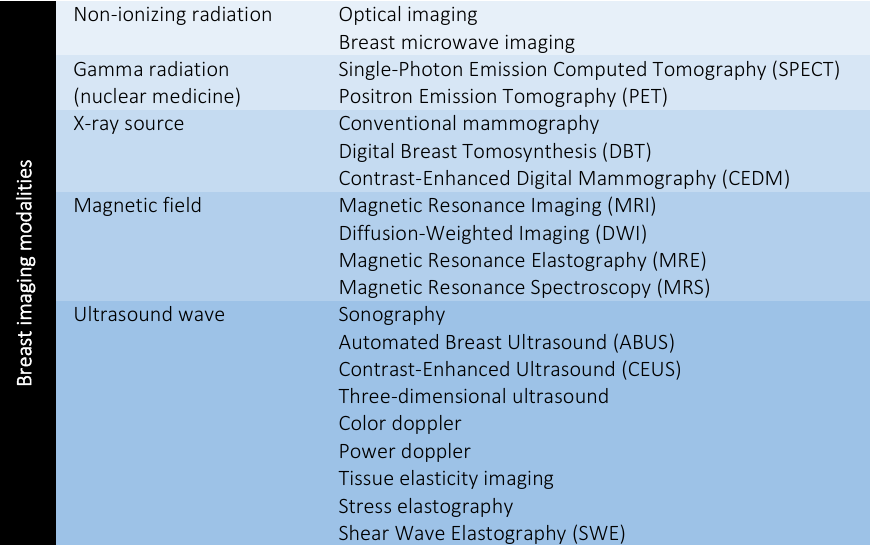
Figure 2. Breast imaging modalities. Figure reproduced from [34] under Creative Commons CC BY license, Springer Nature.